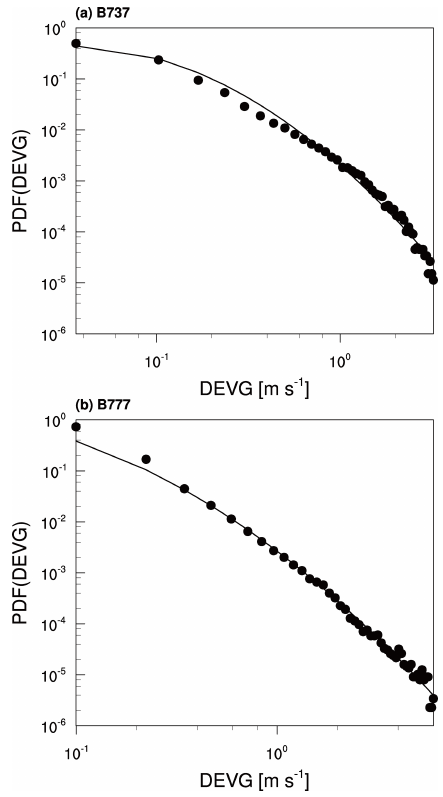
Figure 7. The probability density functions (PDFs) of the DEVG and lognormal fits (line) over the DEVG for the (a) B737 and (b) B777 accumulated for the 12 months from January to Decem- ber